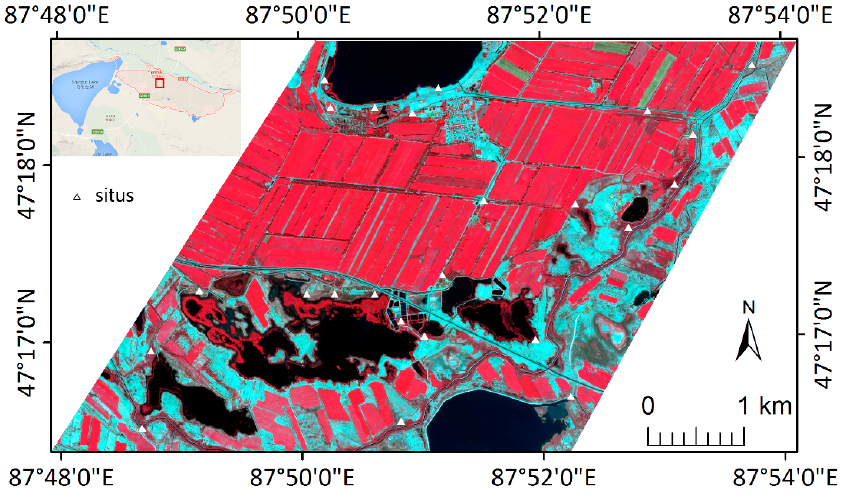
Figure 1. The geographic location of the study area.